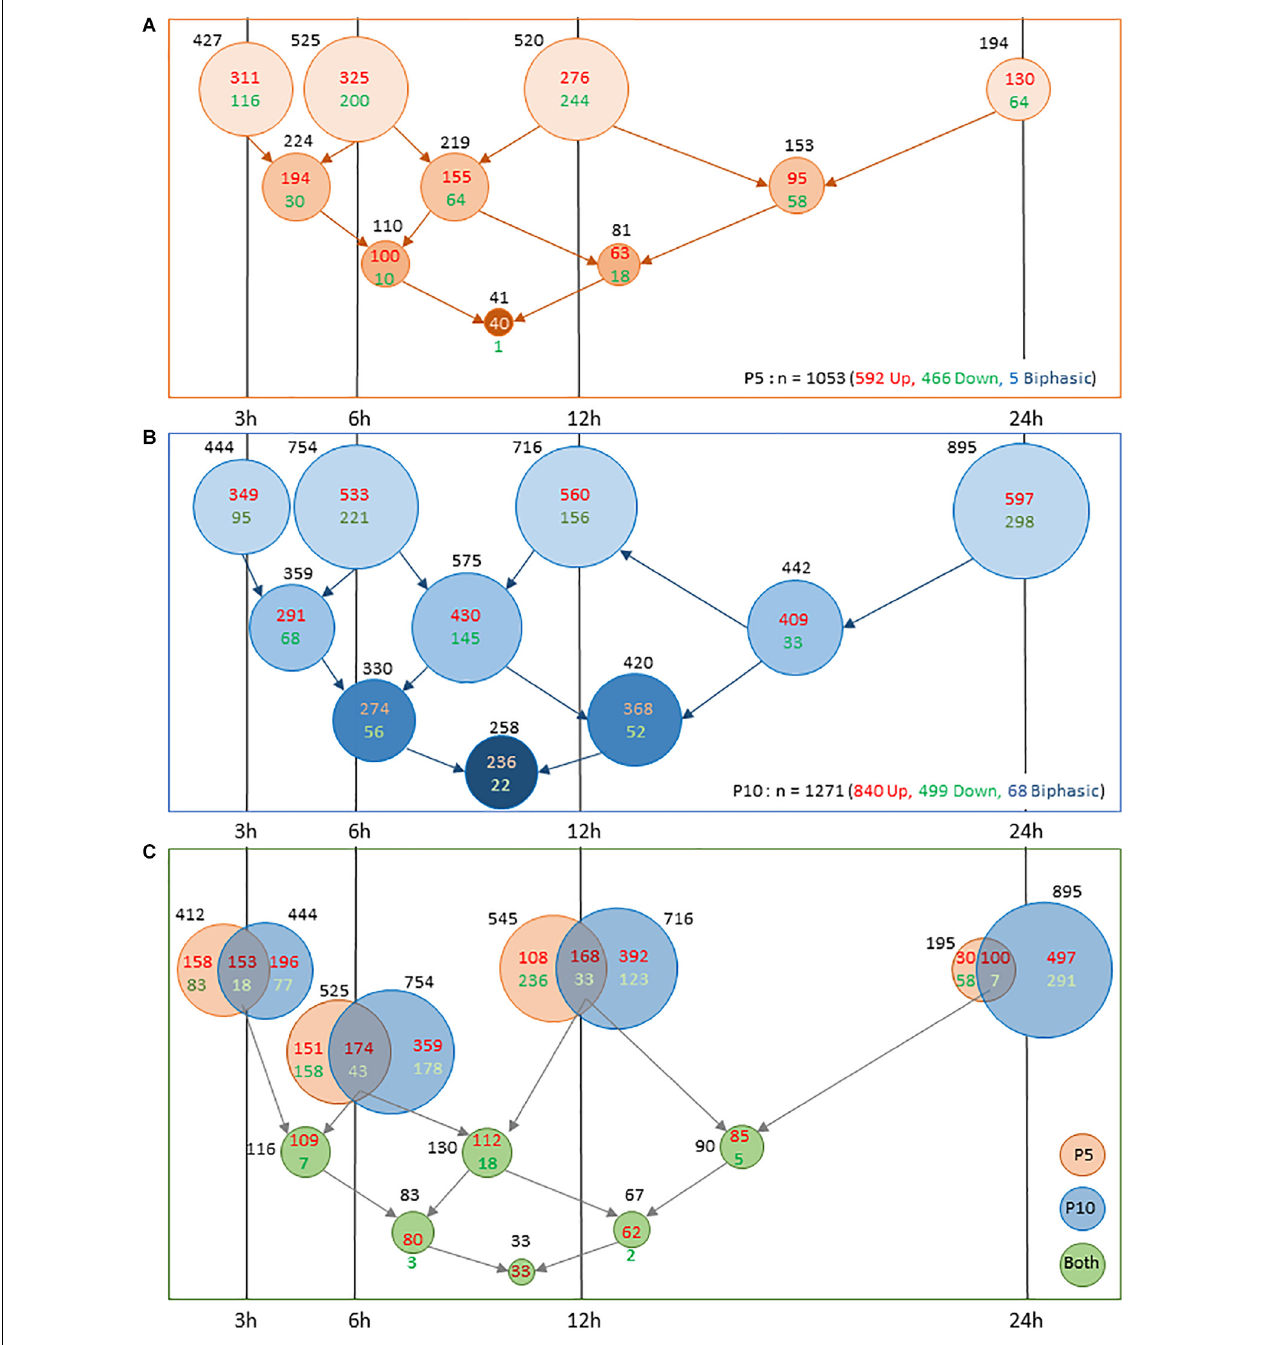
FIGURE 3 | Comparison of number of genes exhibiting transcription response to HI in P5 or P10 brains at the different time intervals post HI. (A) Distribution in P5 mice. (B) Distribution in P10 mice. Lower series of circles indicate numbers of genes present in successive intervals. (C) Coincident transcription responses in P5 and P10 brains at 3, 6 12, and 24 h after HI. Circles overlappings indicate common responses. Bottom rows indicate numbers of common observations at consecutive time points. Induction numbers were noted in red and repressions in green. Disk surfaces were proportional to gene numbers (noted in black).